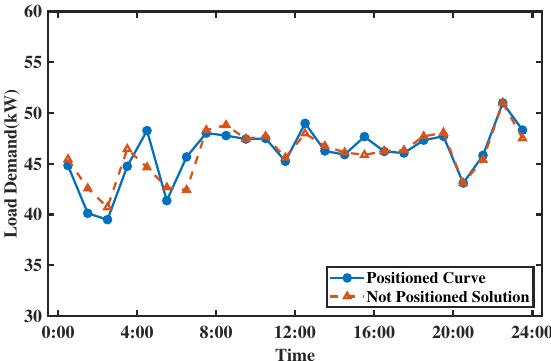
Figure 13. Demand load curve before/after positioning shiftable loads’ operating time-slots.